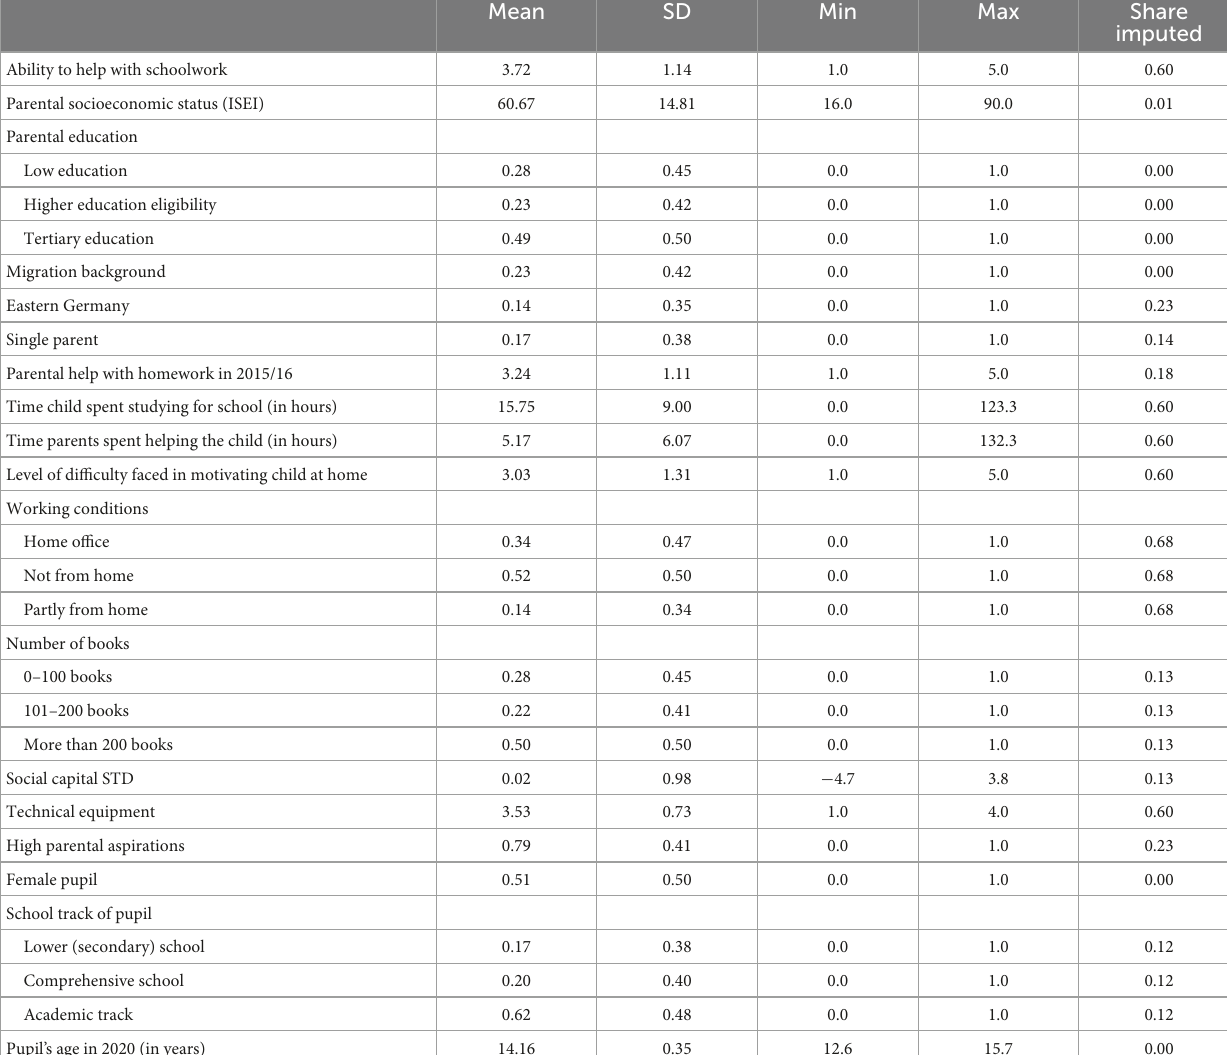
TABLE 1 Descriptive statistics of the complete